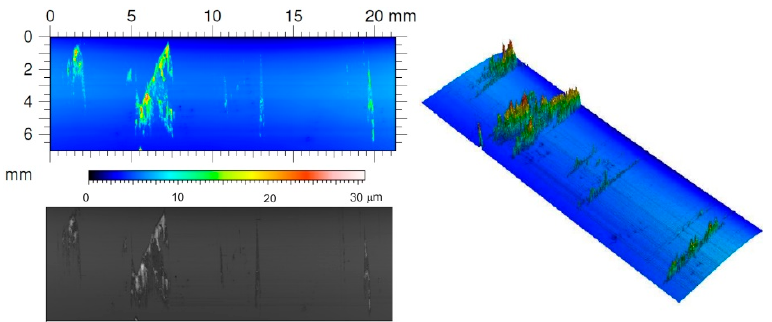
Figure 8. Topography of polished tool surfaces made of NC10 steel after drawing titanium Grade 2 strips.